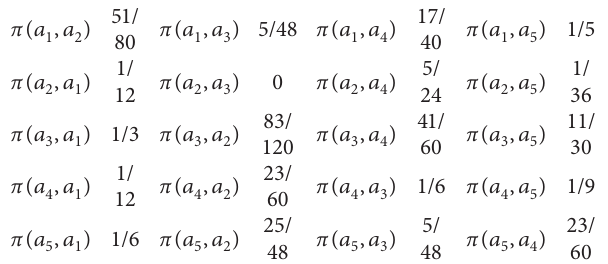
Table 11: Industry criteria deviation. Table 12: Industry criteria priority index.